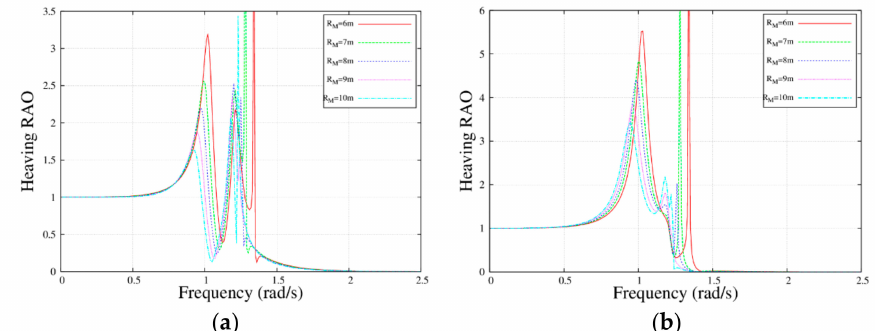
Figure 7. Response amplitude operator with the frequency for the MP and the WEB with di ff erent radius; R M = 6, 7, 8, 9, and 10 m. ( a ) X M , d M = 6 m and ( b ) X B , d M = 6 m.